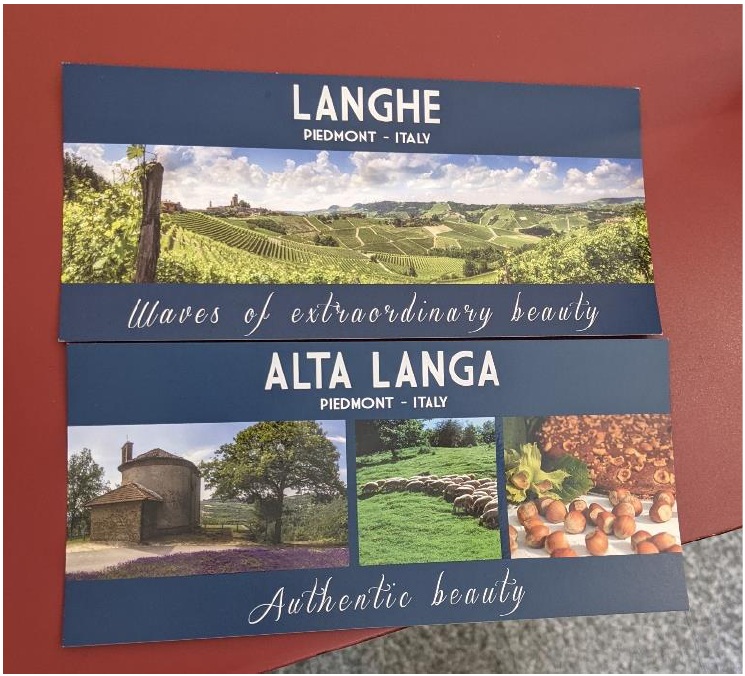
Figure 6. The Alta Langa is today presented in marketing advertisement as an “Authentic Beauty”.